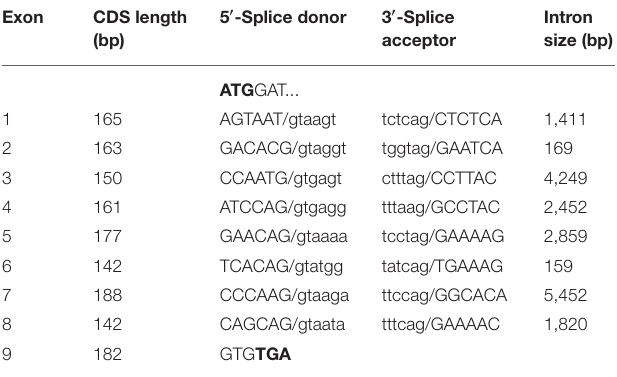
TABLE 3 | Exon-intron organization of the canine CYP2C41 gene. TABLE 4 | Exon-intron organization of the canine CYP2C21 gene.